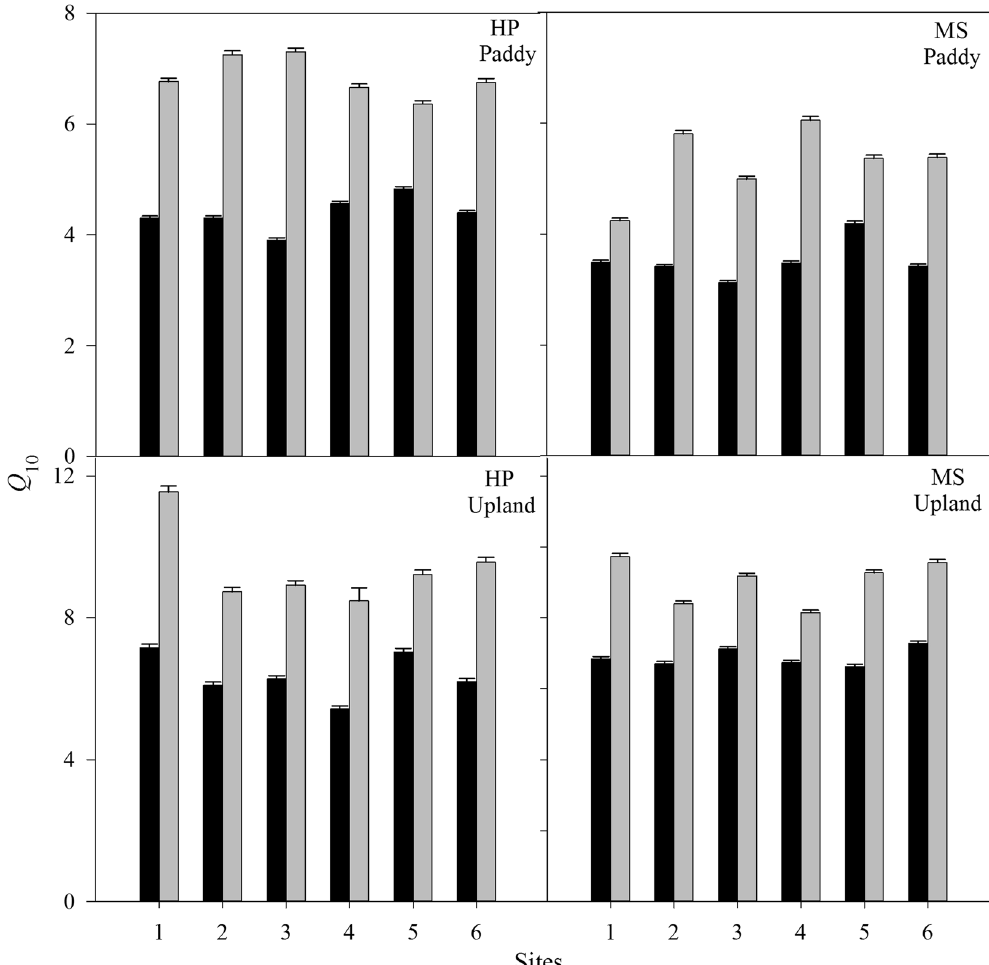
Figure 3. The Q 10 value for topsoil layer (TL, black bars) and subsoil layer (SL, gray bars) of paddy field and upland soils. Error bars indicate standard deviation (n = 4). Means are average Q 10 values for six sites. HP and MS represent Huaping and Meishan, respectively.